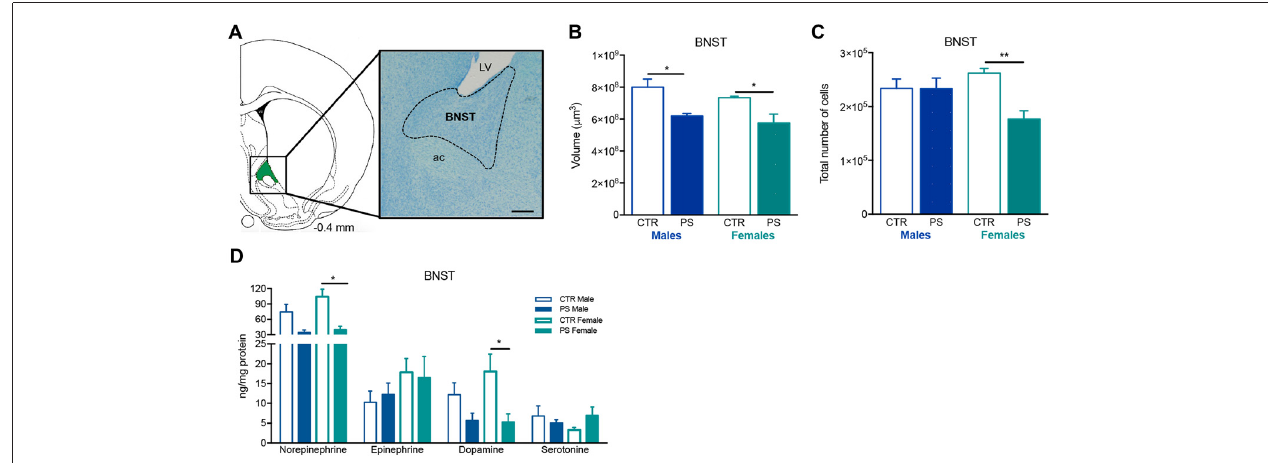
FIGURE 4 | Exposure to prenatal mild stress alters the structure and neurochemical content of the bed nucleus of stria terminalis (BNST). (A) Representative image of the BNST anatomy, using a methacrylate coronal section of a rat’s brain; numbers represent distance to Bregma; scale bar = 1 mm. (B) PS animals of both genders show a significant reduction in the volume of the BNST (n PS males = 7, n CTR males = 4, n PS females = 4, n CTR females = 4). (C) Females also present a decrease in the total number of cells (n PS males = 4, n CTR males = 3, n PS females = 3, n CTR females = 4), whereas males present a similar number as CTR. (D) HPLC measurement of catecholamines revealed that the BNST of female PS animals present a reduction in norepinephrine and dopamine levels in comparison with CTR female rats, and there is a trend for decreased levels of the same amines in male PS rats; no major differences were found in other neurotransmitter levels (n PS males = 4,